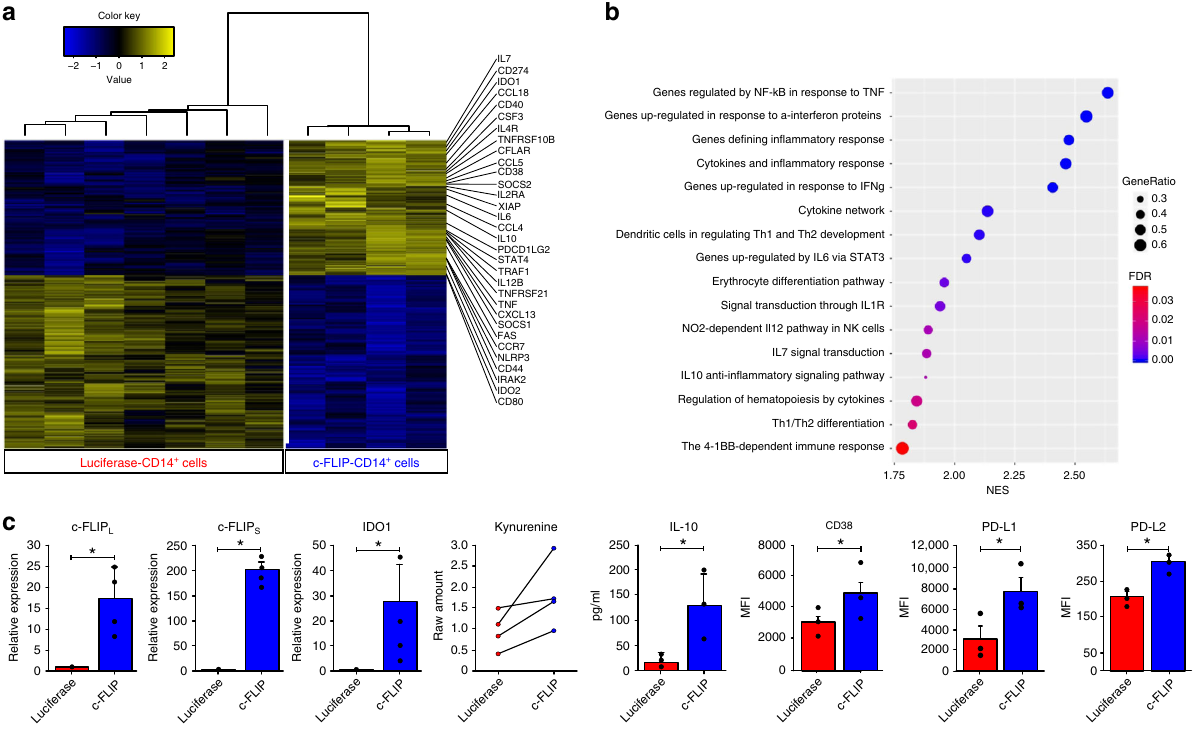
Fig. 4 Infected c-FLIP expressing CD14 + cells activate MDSC-associated molecular programs. a Supervised clustering of c-FLIP arrays using 1,552 differentially expressed genes (FDR <0.01 and absolute fold change >2). b Gene set enrichment analysis (GSEA) for association between c-FLIP overexpression and Hallmark ( n = 50) and Biocarta ( n = 217) gene sets denoting the activation of speci fi c signaling pathways with a statistical con fi dence of 95%. NES, normalized enrichment score; FDR, false discovery rate q -value; GeneRatio, the percentage of gene hits before the peak in the running enrichment score used as an indication of the percentage of genes contributing to the enrichment score. Dotplot was generated using the ggplot function of the ggplot2 R package. c Validation of immune markers induced by c-FLIP in monocytes was performed by real-time PCR (c-FLIP L , c-FLIP S , and IDO1), by high-performance liquid chromatography (HPLC) in culture supernatants (kynurenine production), by ELISA quanti fi cation of culture media (IL-10) and fl ow cytometry (CD38, PD-L1, and PD-L2). Data are presented as mean ± s.e.m. of fi ve independent experiments ( c ). * P < 0.05, ** P < 0.01; *** P <